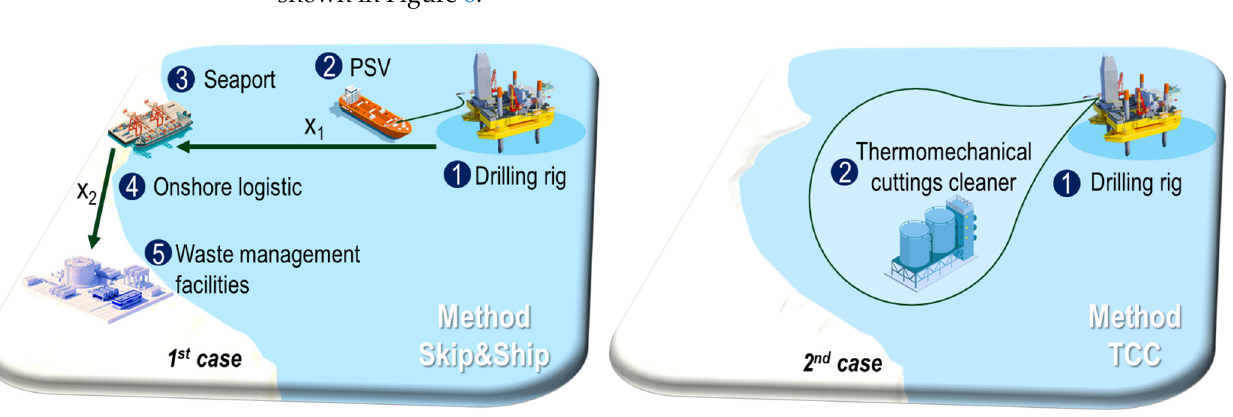
Figure 6. Two cases for waste management.